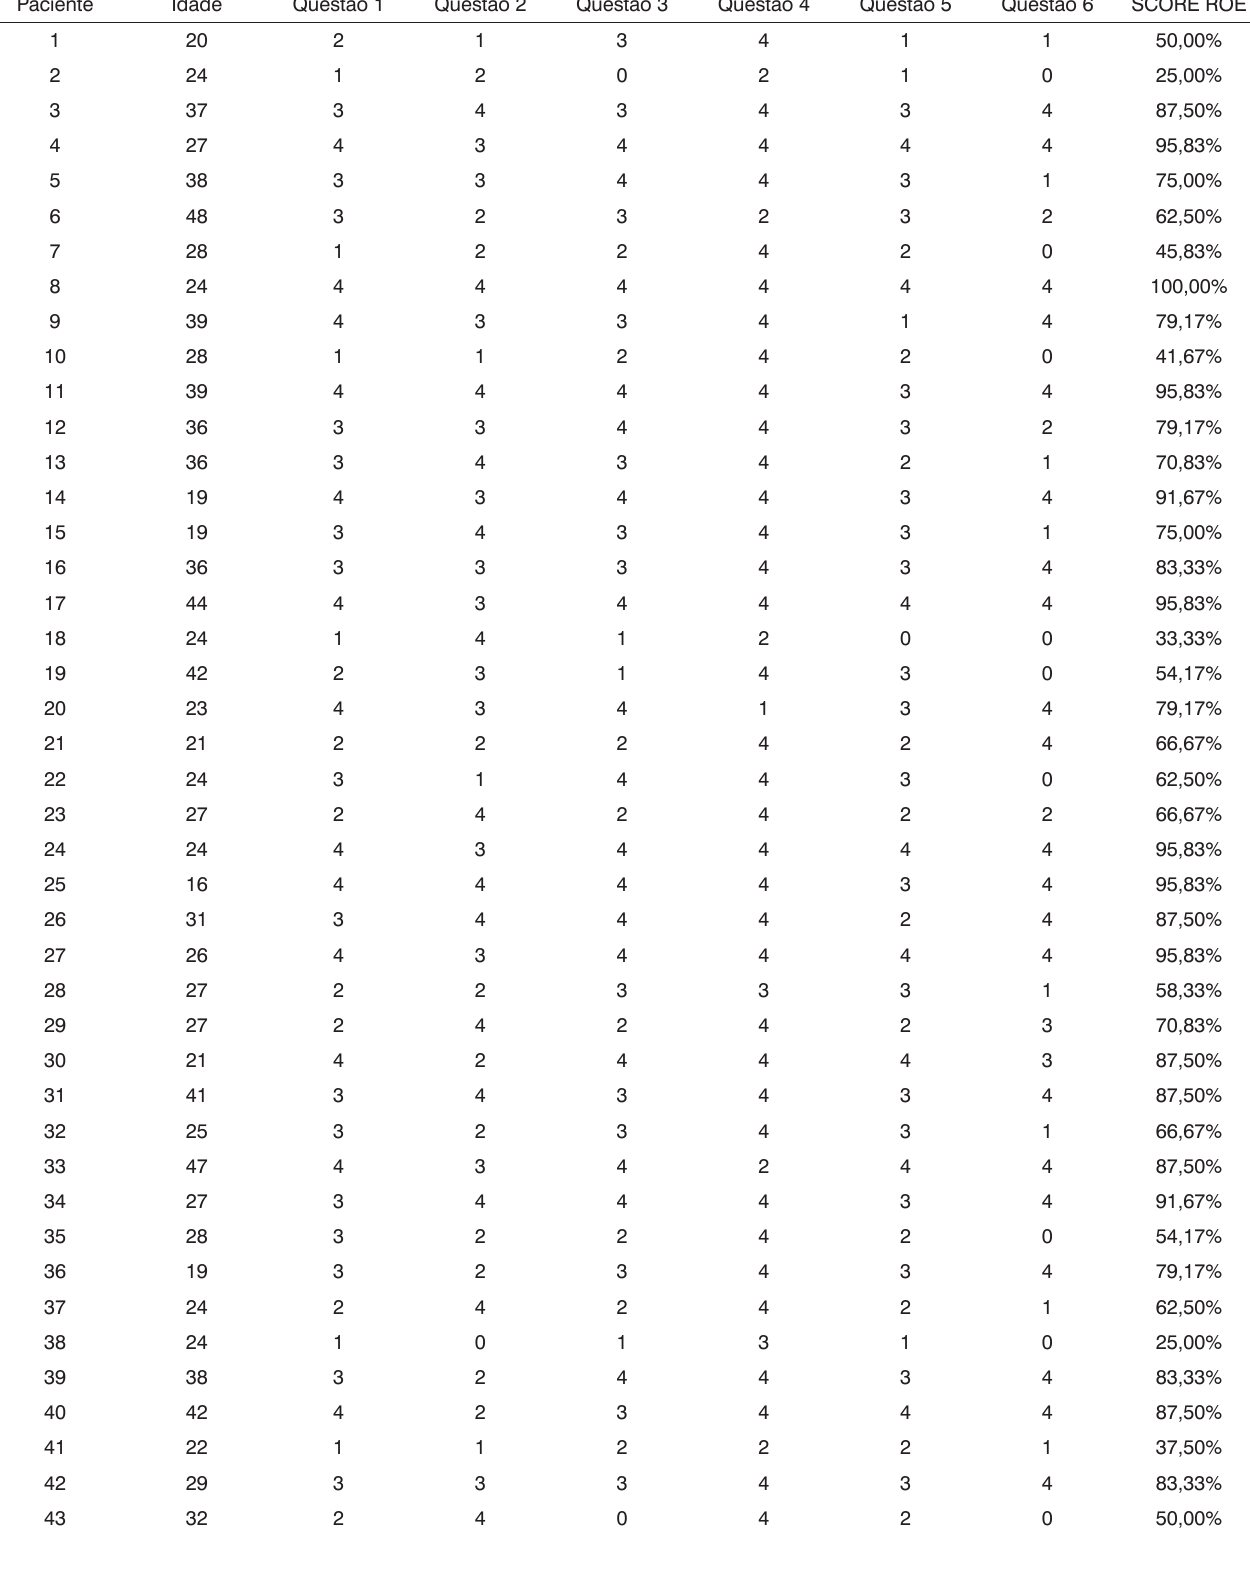
Tabela 1. Pacientes submetidos à rinoplastia